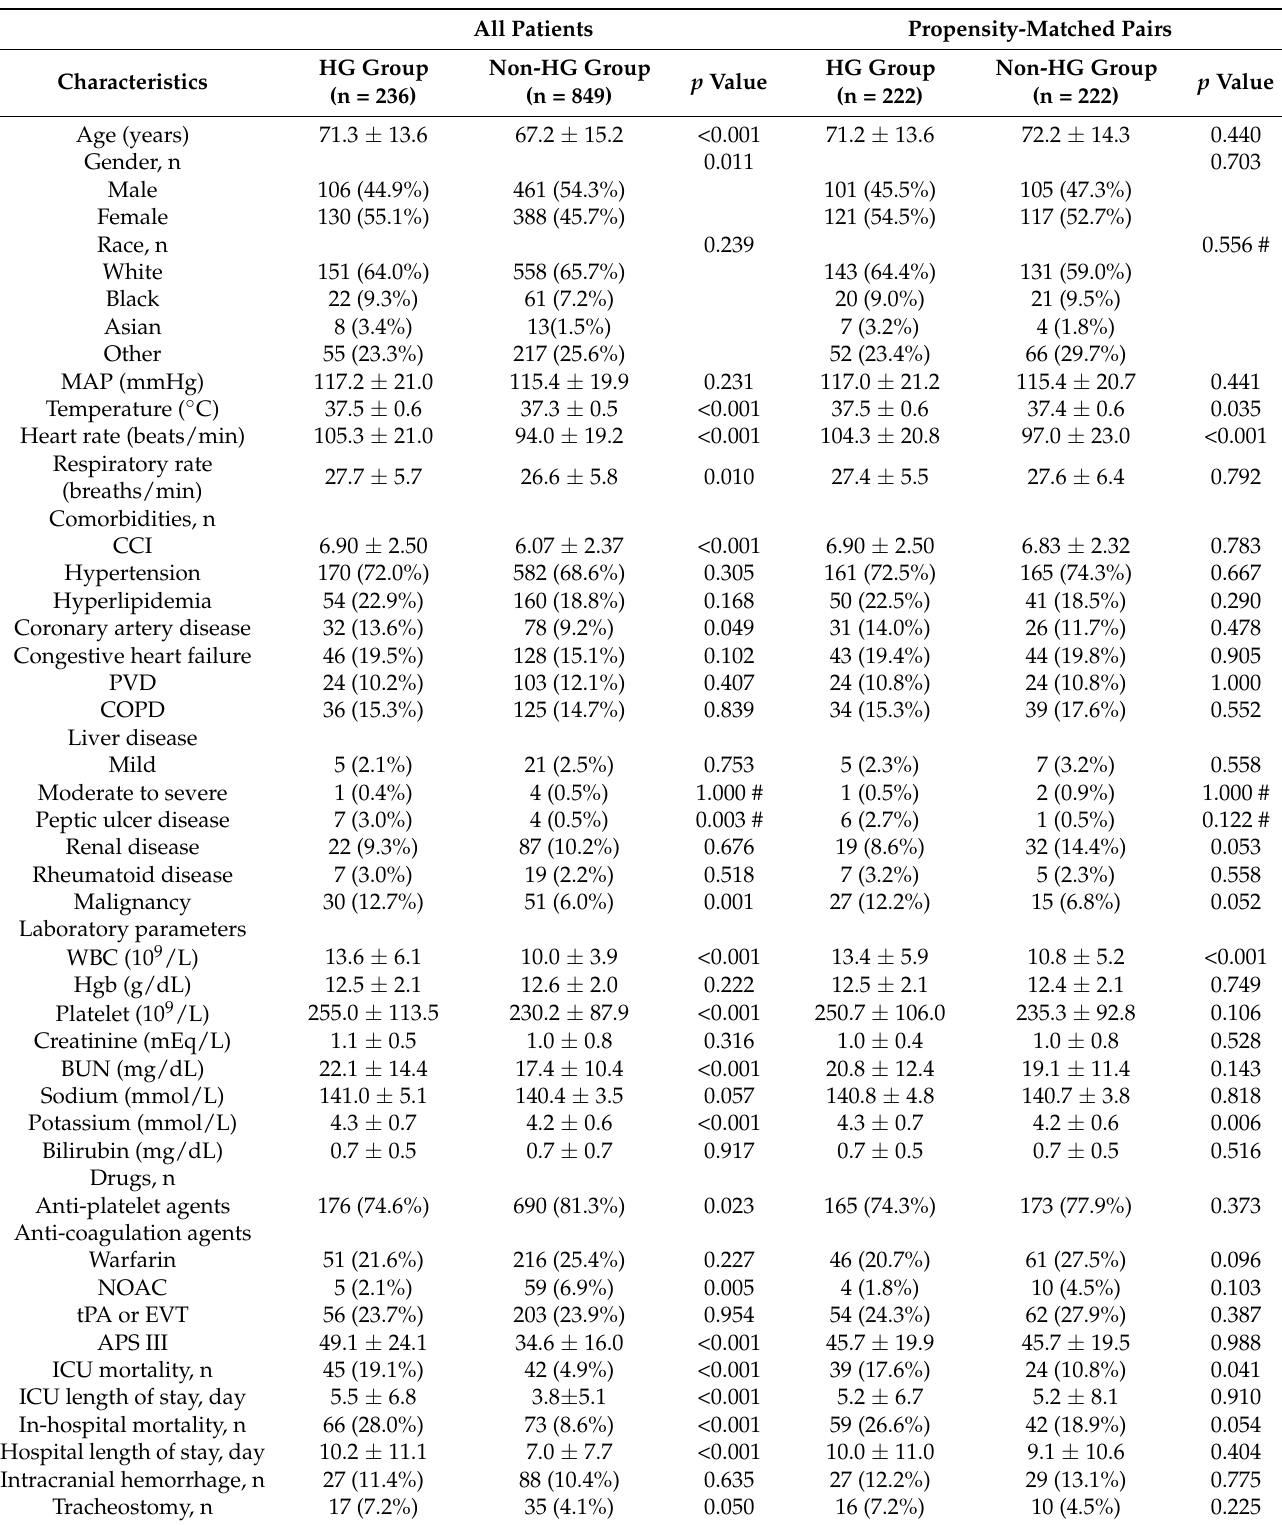
Table 1. Characteristics of the study